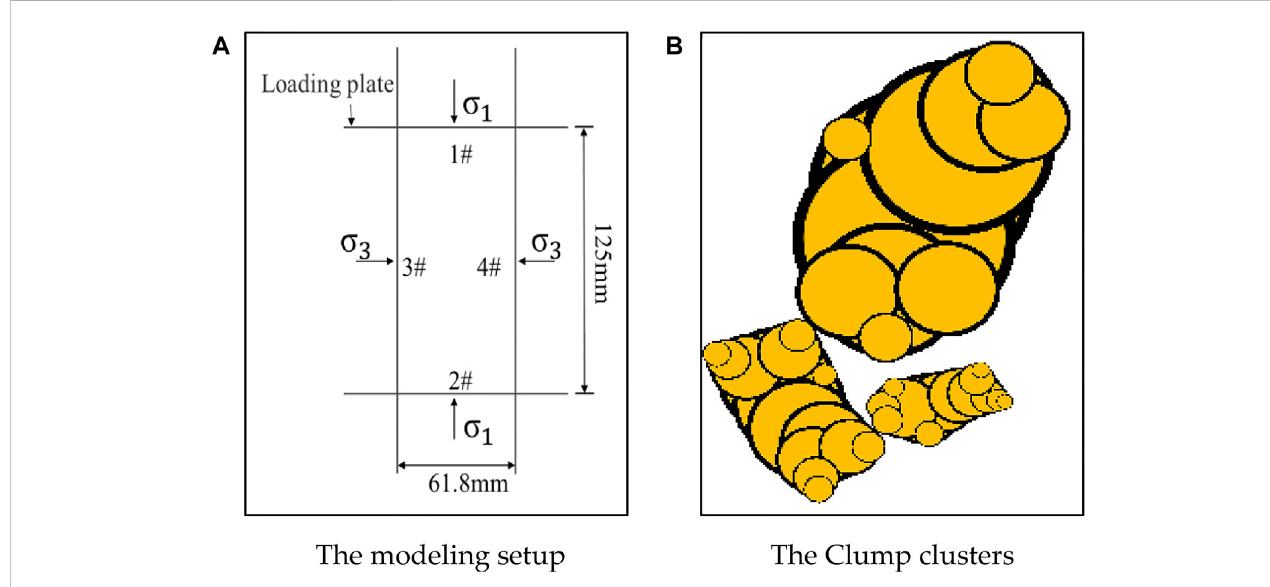
FIGURE 6 Numerical simulation model for standard triaxial tests: (A) The modeling setup, (B) The clump clusters.